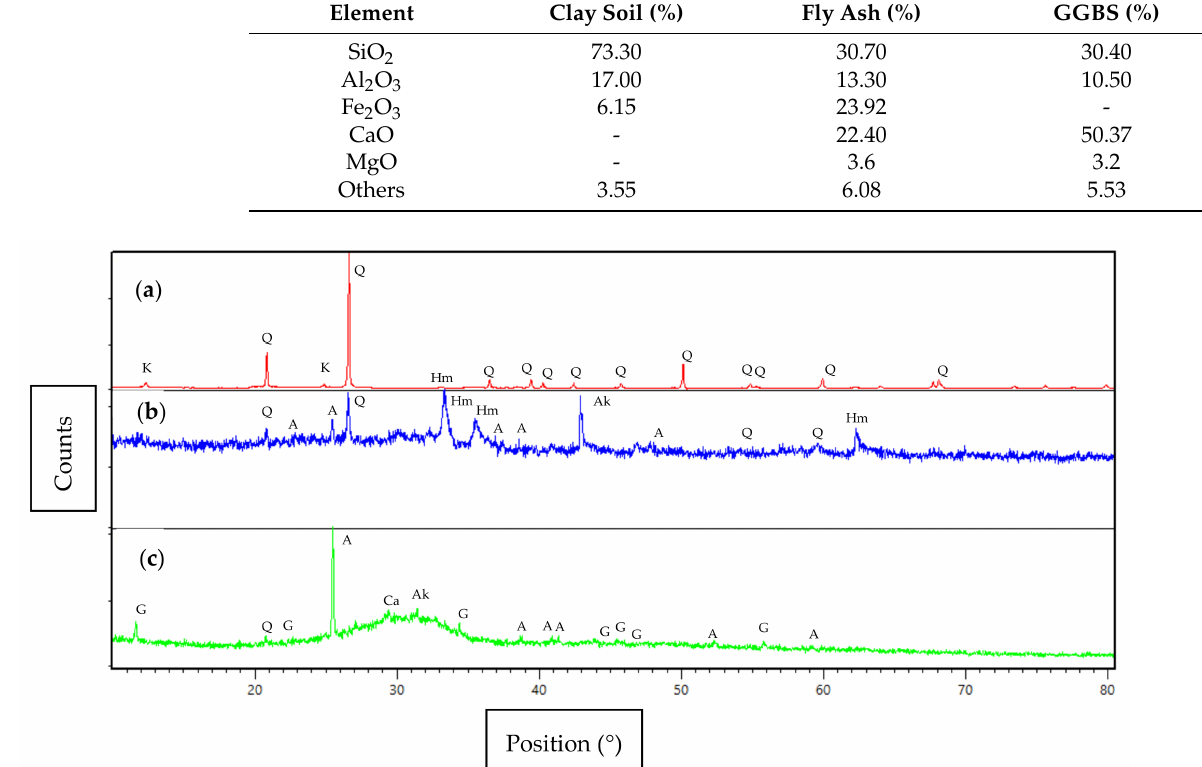
Figure 1. XRD patterns of ( a ) soil, ( b ) fly ash and ( c ) GGBS. Q: quartz (ICDD reference: 00-046-1045); K: kaoline